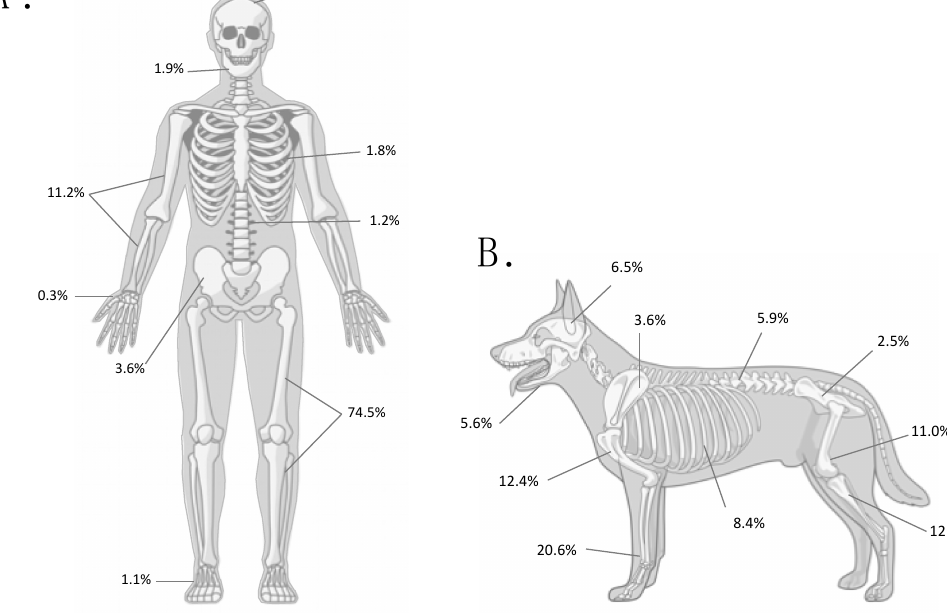
Figure 2. Anatomic distribution of osteosarcoma in humans ( A ) and in dogs ( B ). Numbers indicate the percentage of cases at each anatomic site out of all osteosarcomas in adolescent humans ( < 24 years old; n = 1855) [1], and the mean percentage at each anatomic site compiled from five canine studies ( n = 1346) [3,9,16,63,64]. Only the most common skeletal sites are included; therefore, percentages do not add up to 100%.